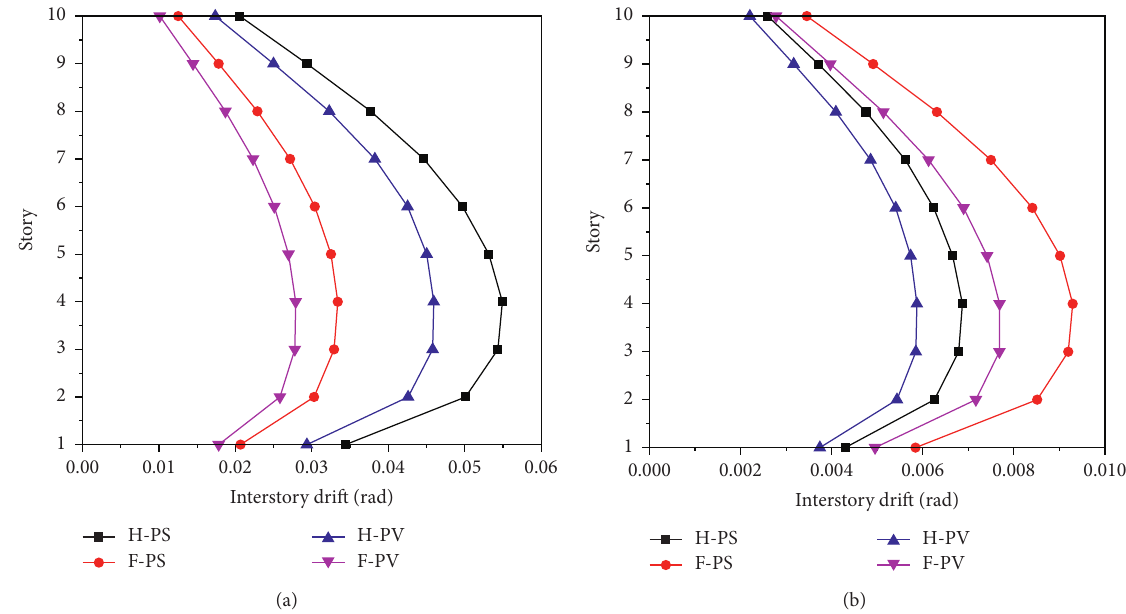
Figure 8: The average peak interstory drift of the structure under the hanging wall and footwall seismic excitations: (a) without amplitude modulation; (b) with amplitude modulation.